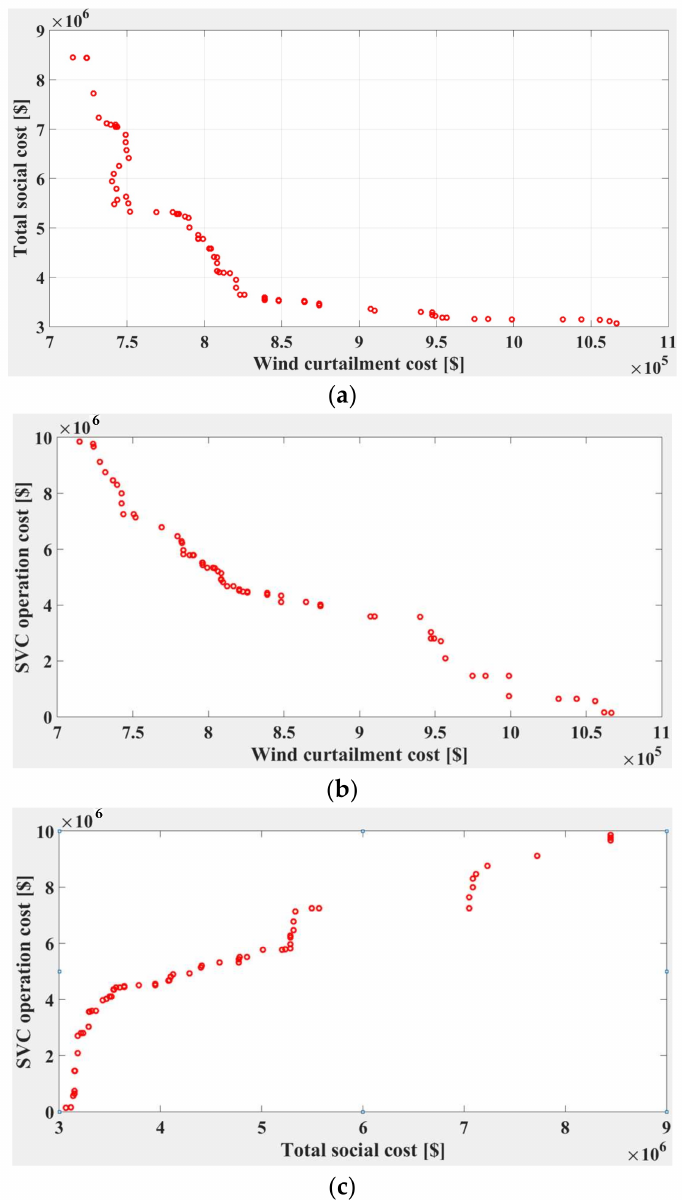
Figure 4. Various non-dominated solutions: ( a ) Total social cost vs. wind curtailment cost. ( b ) SVC operation cost vs. wind curtailment cost. ( c ) SVC operation cost vs. total social